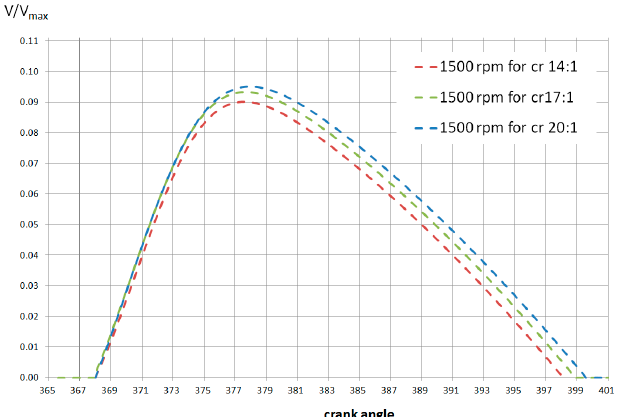
Figure 7. Comparison of volume changes in the complementary system for the rotational speed of 1500 rpm and different stages, respectively: cr = 14:1, cr = 17:1 and cr = 20:1.